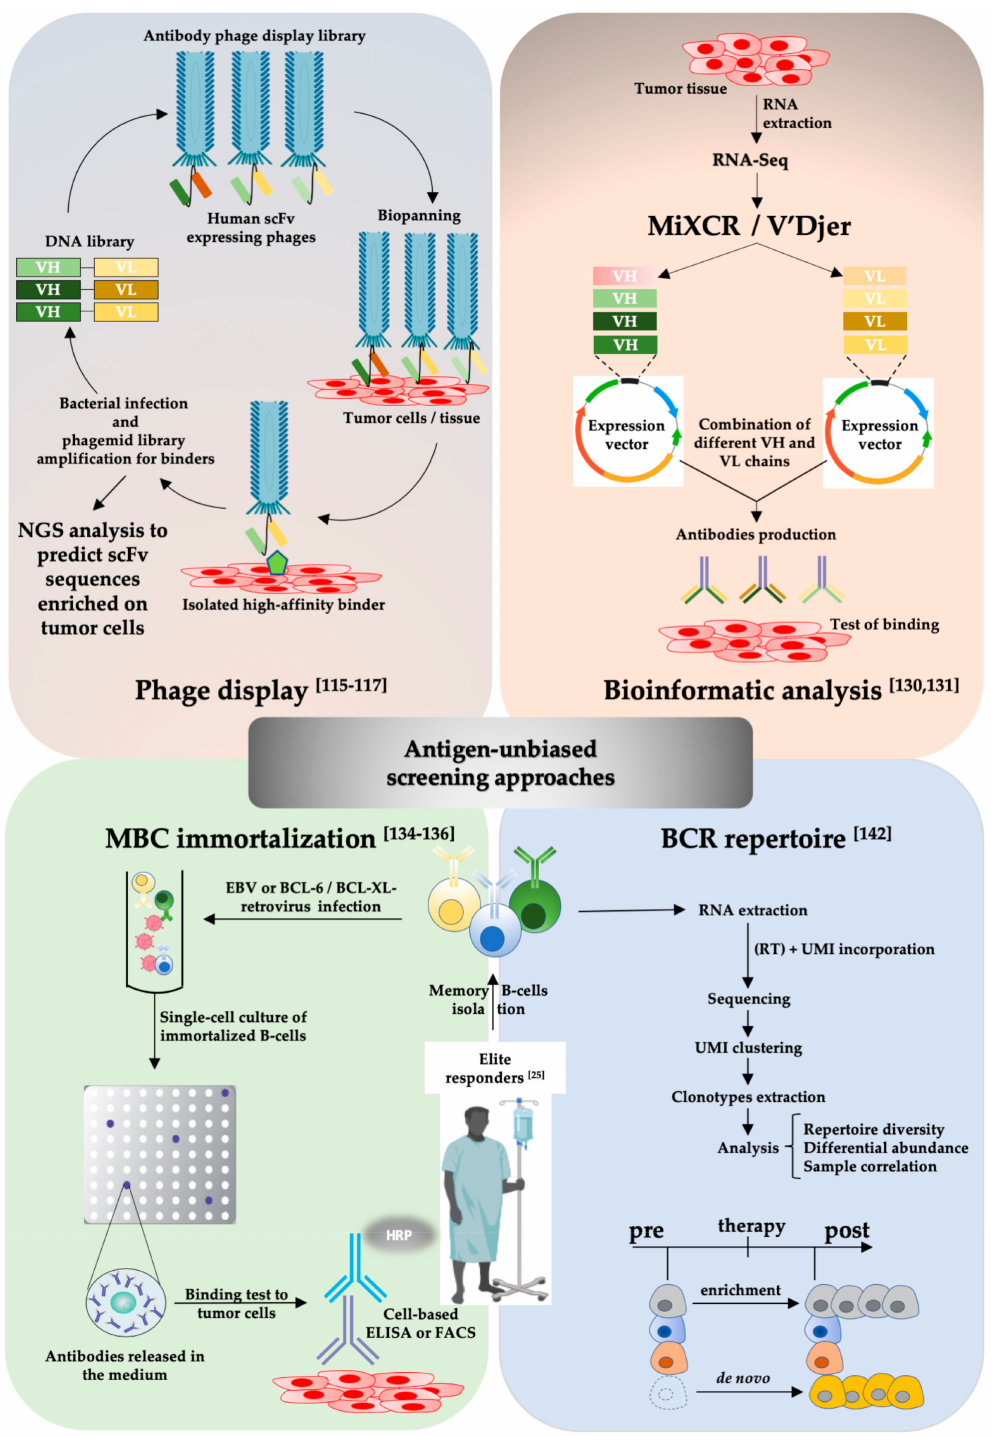
Figure 2. Schematic representation of 4 antigen-unbiased screening strategies to obtain fully human tumor-targeting